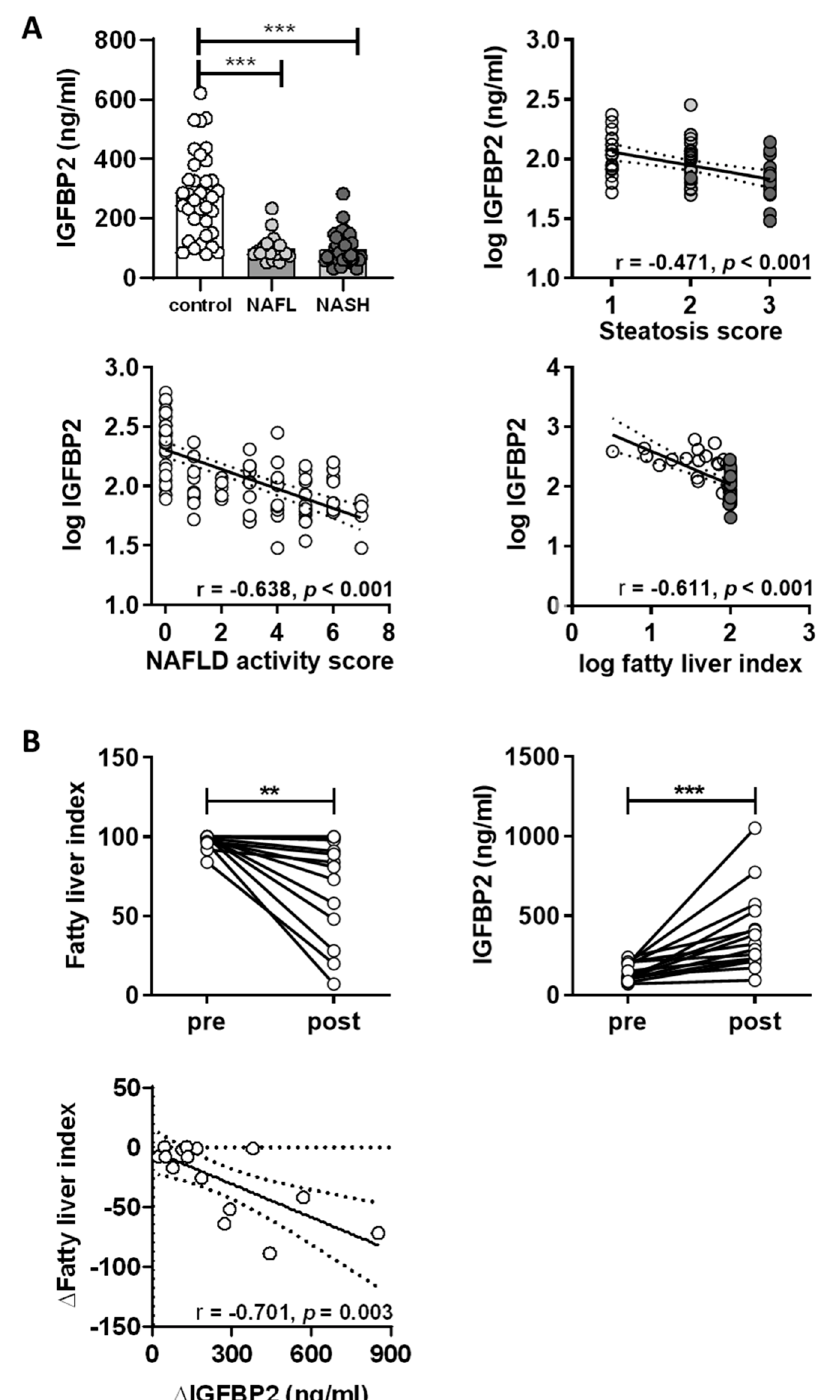
Figure 6. IGFBP2 plasma levels in obese men with NAFLD. ( A ) Circulating IGFBP2 levels in men without obesity ( n = 36), and biopsy-proven NAFL ( n = 20) and NASH ( n = 42), and correlates between IGFBP2 levels with histology steatosis score, NAFLD activity score, and fatty liver index. ( B ) Effect of bariatric intervention on fatty liver index, IGFBP2 serum concentration, and regression analysis for the change ( Δ ) in fatty liver index versus the change in IGFBP2 levels in class III obese men before (pre) and two years after (post) bariatric surgery. Bar graphs show mean (±95% CI), scatter plots show regression lines (±95% CI, dashed lines). Statistics: ANOVA with Sidak correction. Pearson’s r and p - values are shown for correlation analysis. ***, ** indicate p < 0.001 and p < 0.01.